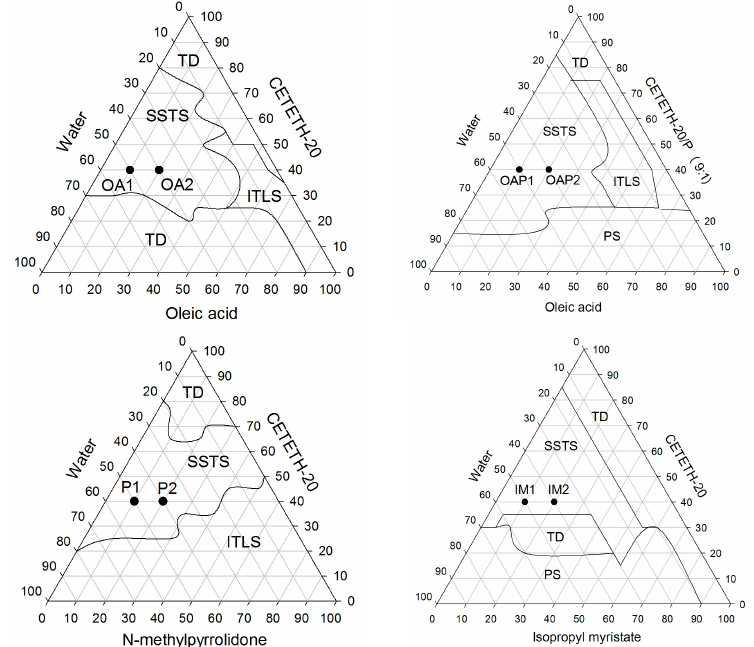
Figure 2. Ternary phase diagrams of CETETH 20 combined with oleic acid (OA), N -methylpyrrolidone (P), and isopropyl myristate (IM) as oily phases. OA1, OA2, IM1, IM2, OAP1, OAP2, P1, and P2 were the points chosen for characterization. (TD) translucent dispersion, (SSTS) semi-solid transparent systems, (ITLS) isotropic transparent liquid system, and (PS) phase separation. Lyotropic liquid crystals that are anisotropic and rotate the polarization plane result in various patterns of colors and texture. Hexagonal structures lead to fan-like images and lamellar phases have “strip-like” structures [15] as can be observed in Figure 3. In this way, samples P and IM are potential hexagonal phases and OA and OAP can be lamellar phases.